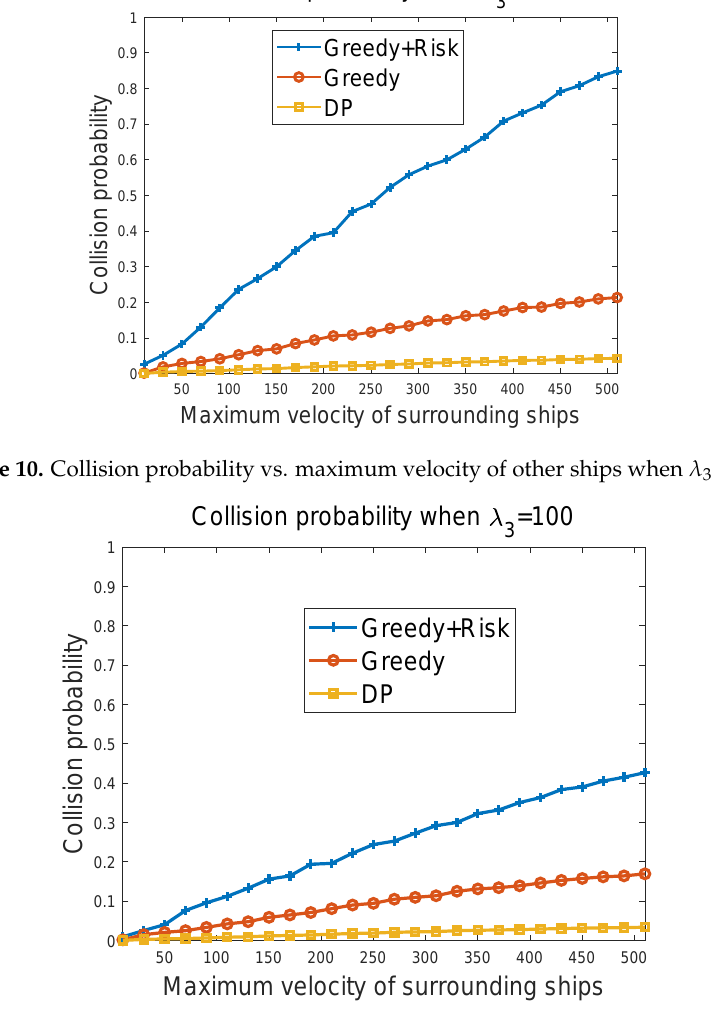
Figure 11. Collision probability vs. maximum velocity of other ships when λ 3 = 100.